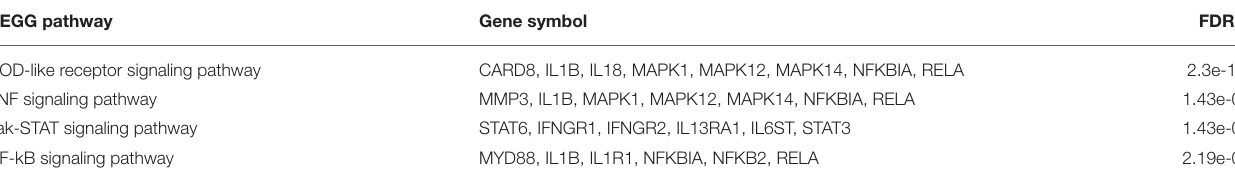
TABLE 2B | CBD negatively modulated the transcription of genes involved in NOD-like receptor signaling pathway and other inflammatory pathways. KEGG pathway